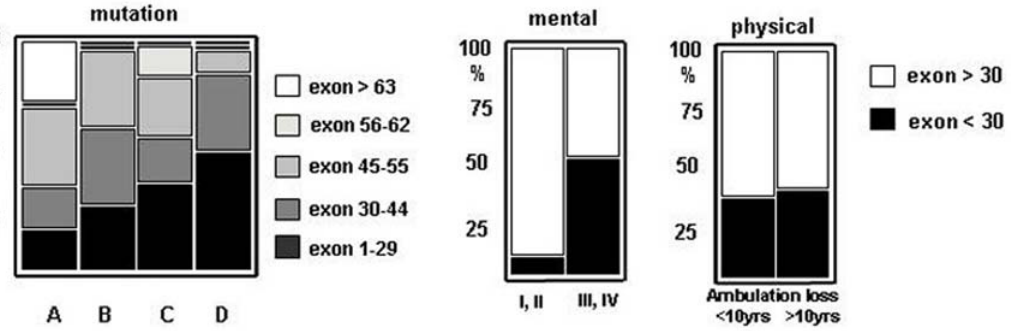
Figure 5. Genotype/phenotype correlations. Proportion of patients with a mutation upstream to exon 30 steadily increased from group A to D. This ascent correlated with spared cognition (mental status: p , 0.0003) but not with motor function (age at ambulation loss: NS) (Fisher’s exact test). Expectedly, the 3 patients with mutation after exon 63 affecting the brain specific DP71 transcript were classified in group A.